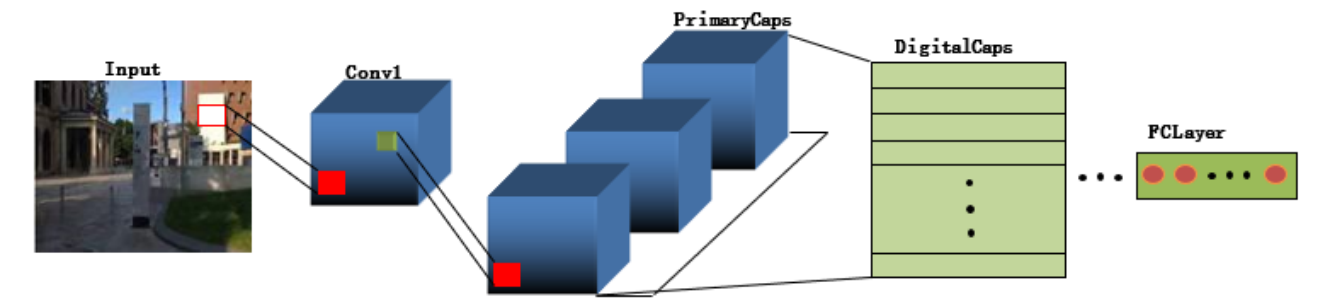
Figure 6. The structure of CapsNet.